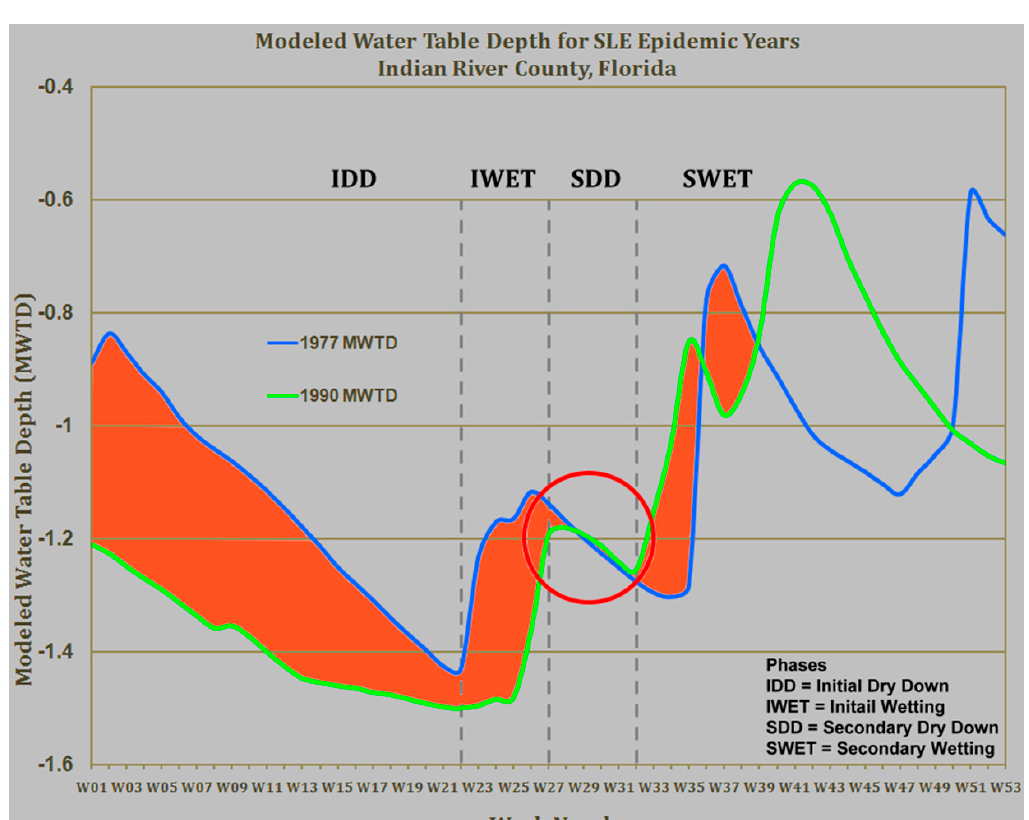
Figure 5. The epidemic signature of rainfall and drought events for WNV and SLEV transmission in Florida. MWTD, modeled water table depth (Courtesy of Jonathan F. Day).